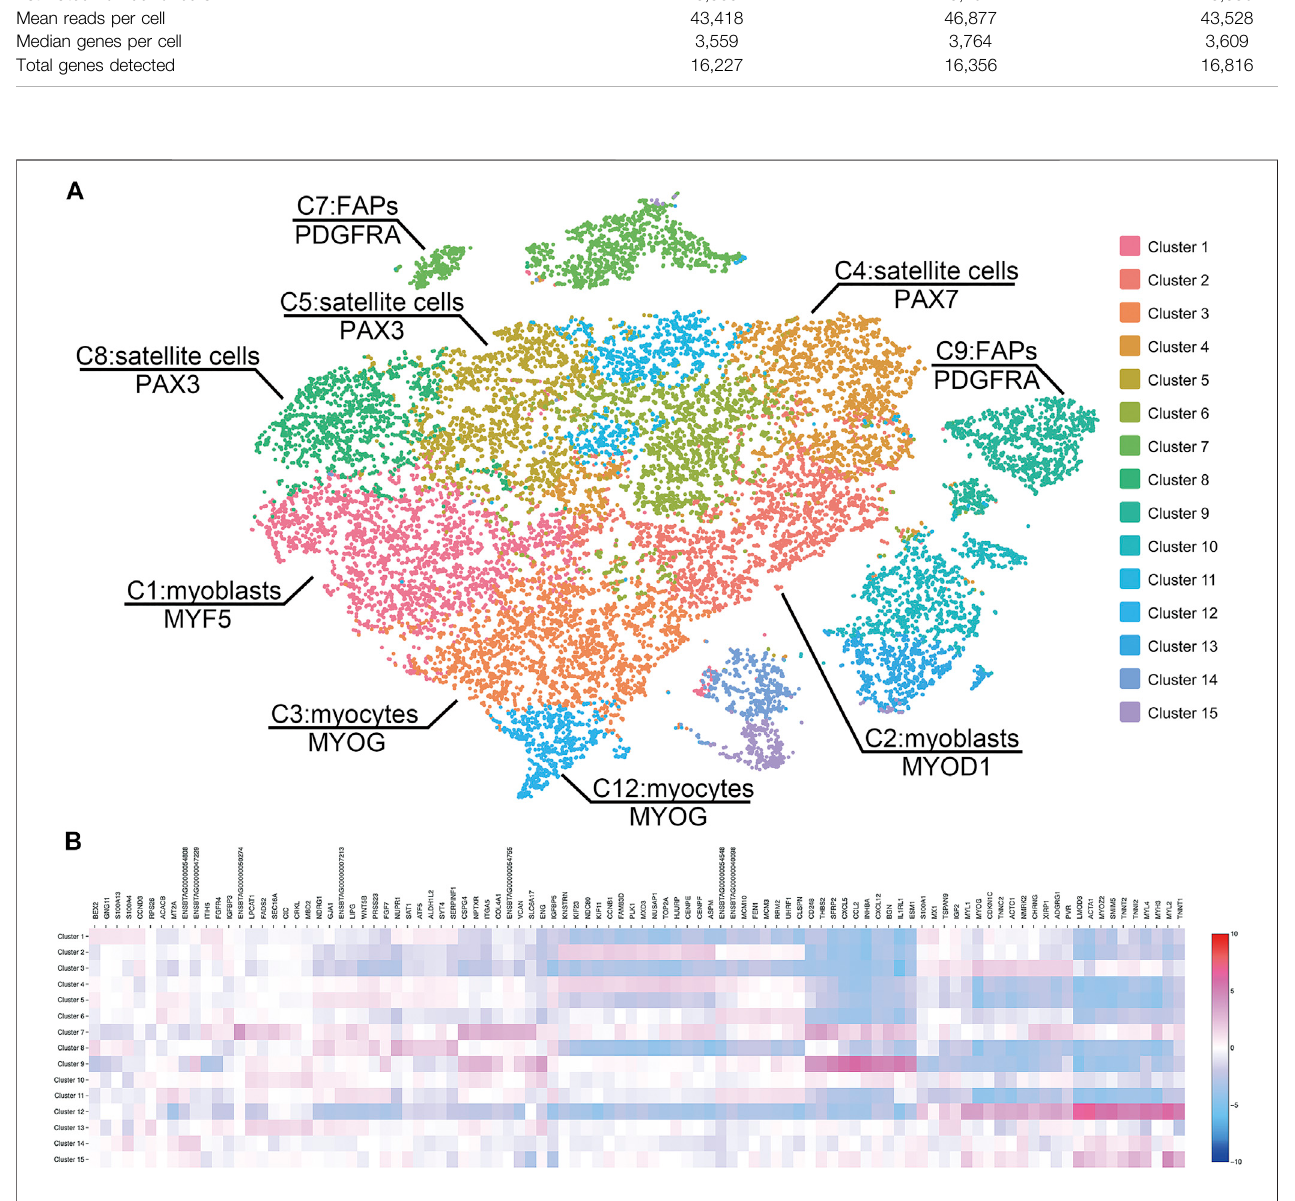
FIGURE 1 | (A) Clustering of cells by the t-distributed stochastic neighbor embedding (t-SNE) algorithm. The 19,096 cultured bovine satellite cells are divided into 15 clusters. Cells close to each other have more similar gene expression patterns than those distant from each other. Cell types are inferred from signi fi cantly enriched expression of known cell markers. FAP, fi bro-adipogenic progenitors. (B) Heatmap of transcriptome similarities between cell clusters. Rows represent cell clusters. Columns represent genes. Shown on top are representative genes. Numbers and colors on the right represent log2 fold changes relative to the median gene expression level across all